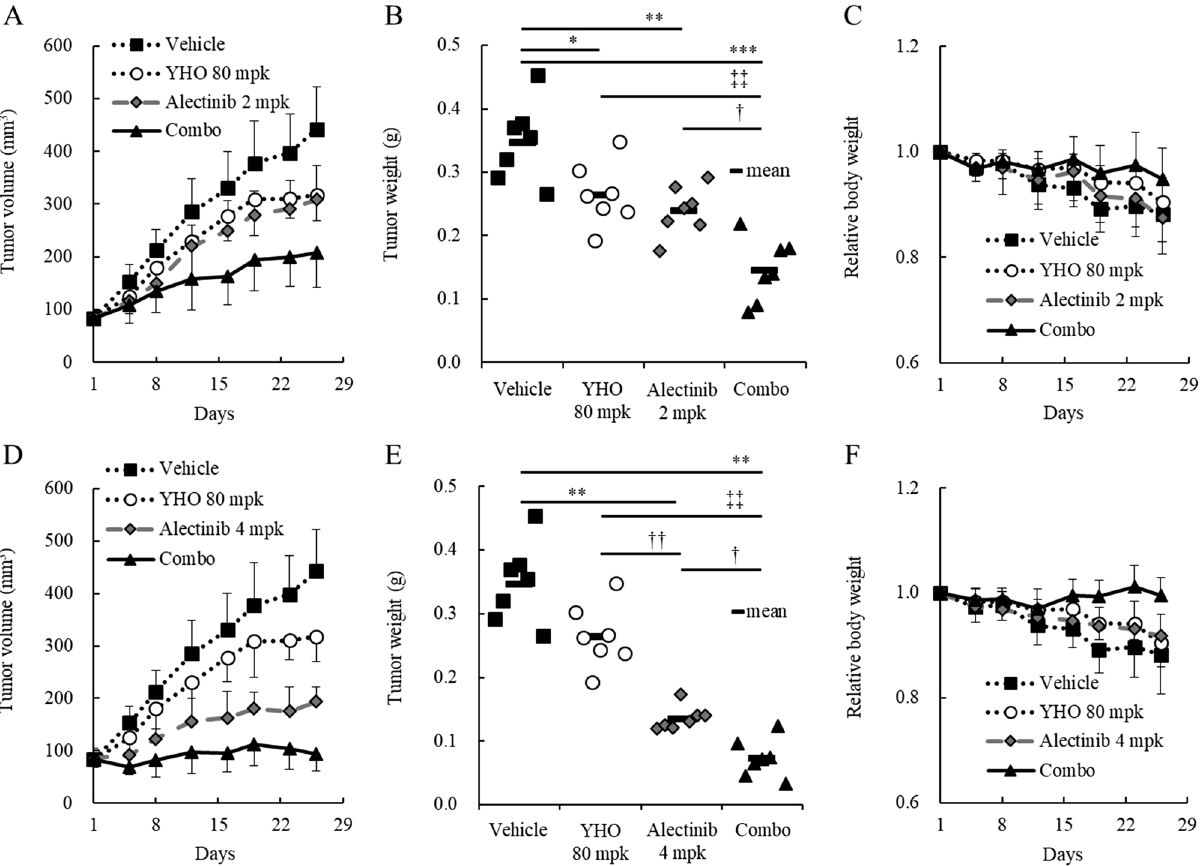
Figure 6. In vivo characterization of orally administered YHO-1701 when combined with alectinib at different levels of efficacy. Alectinib was used at 2 mg/kg/day ( A – C ) or 4 mg/kg/day ( D – F ). H2228 xenograft mice were randomized on day 1. Mice were treated with vehicle, YHO-1701, alectinib, or YHO-1701 + alectinib once daily for 4 weeks using a 5-day on, 2-day off schedule at indicated doses (n = 7). Changes in tumor volume ( A , D ), tumor weight on day 26 ( B , E ), and relative body weight ( C , F ). Significance was determined by Tukey’s test ( B ) or Steel–Dwass test ( E ). *p < 0.05; **p < 0.01; ***p < 0.001 versus the vehicle group. † p < 0.05; †† p < 0.01 versus